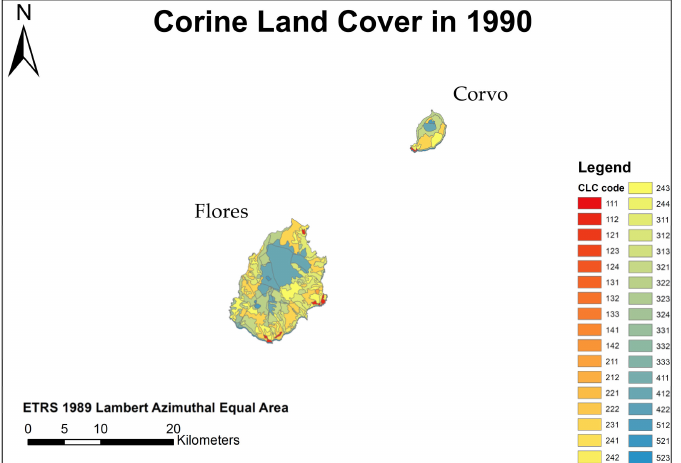
Figure A1. Thematic cartography regarding the land-use changes in the Western Group of Azores Archipelago in the year